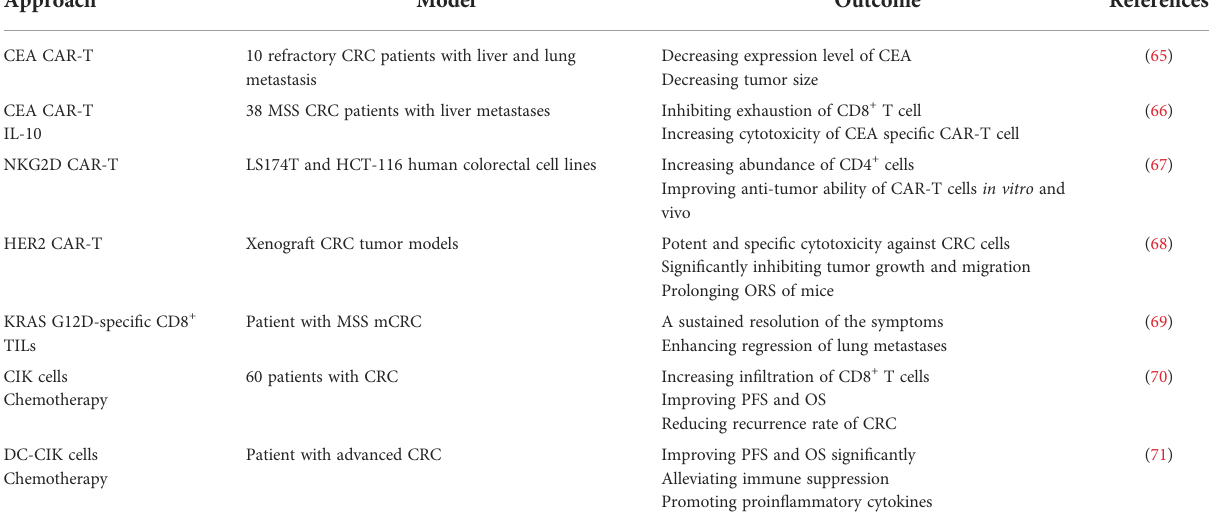
TABLE 2 Different applications of ACT in colorectal